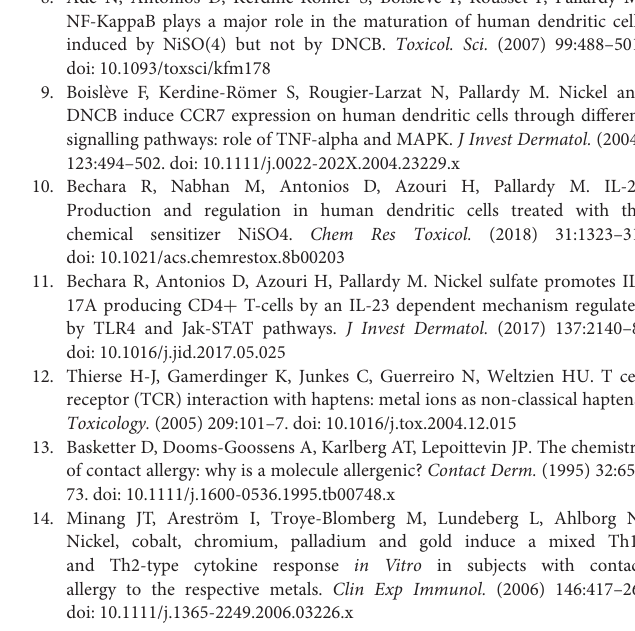
percentage of total reads. The gray dotted line indicates the frequency cut-off of 0.5% for the definition of highly expanded clones (HECs). (b) Impact on the total repertoire of clones with clonal frequency below 0.1% (light gray bars), between 0.1 and 0.5% (dark gray bars) and above 0.5% (black bars) in the six nickel-specific T-cell lines analyzed. TCR β variable gene usage of the HECs in the pre- and post-stimulation repertoire in donor PR19 (c) and PR20 (d) . The percentage of HECs carrying a particular TCR β variable gene (TRBV) is depicted on the y-axis. All the genes names follow the IMGT nomenclature. Supplementary Data 6 | Diversity index of the TCR β repertoire at baseline and in wells after coculture with nickel-loaded DCs. The diversity in the pre-